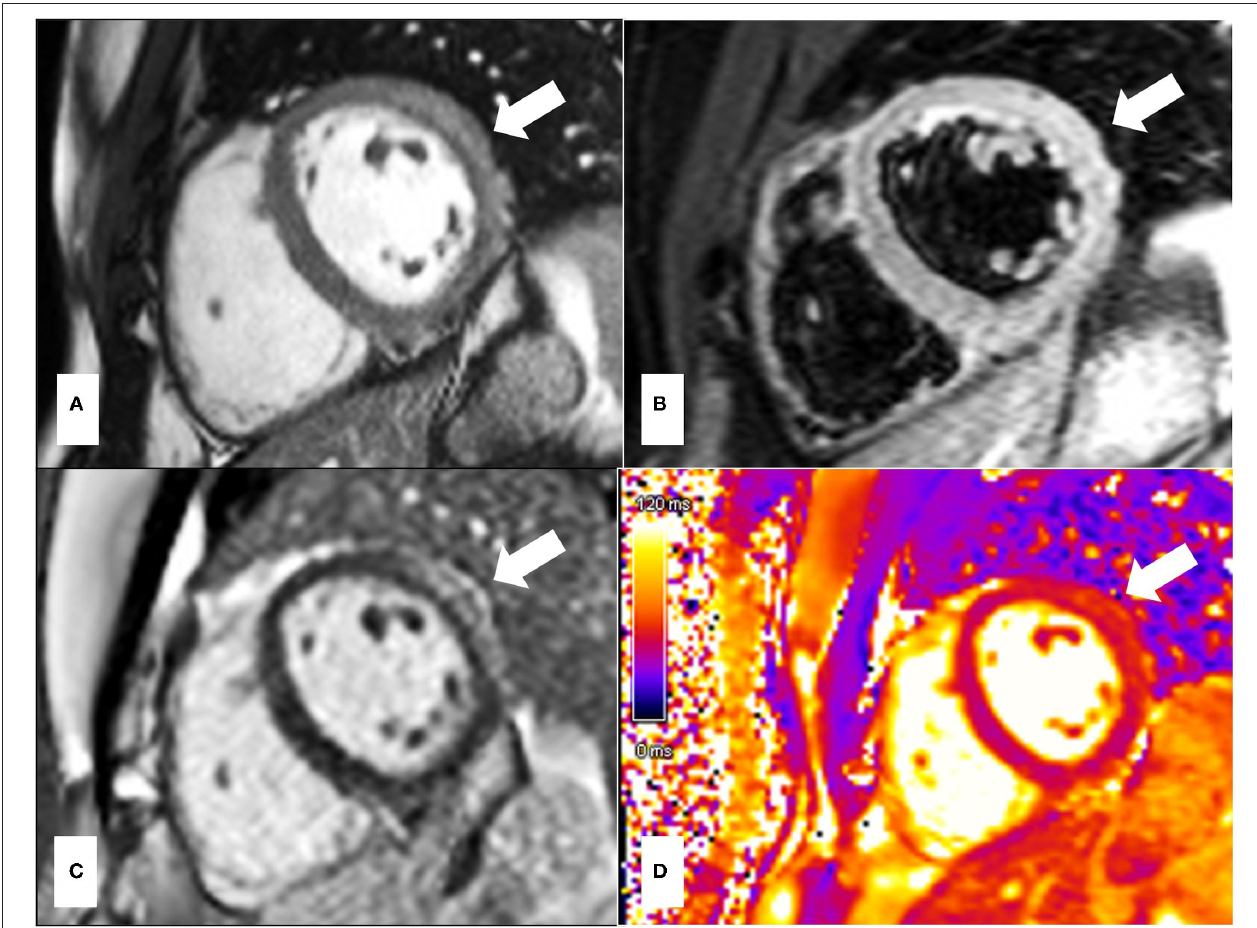
FIGURE 2 | 33-year-old presented with troponin positive chest pain and inferior ST elevation on ECG. He reported recent flu-like symptoms following mRNA COVID-19 vaccination. (A) is the post-contrast steady state free precession (SSFP) cine showing a bright signal intensity in keeping with myocardial oedema due to acute myocardial injury, which is also in keeping with the T2-STIR imaging (B) and T2 mapping (D) images which demonstrate high signal intensity in the mid lateral wall correlating with subepicardial late enhancement on gadolinium imaging (C) . The pattern of myocardial injury noted is in keeping with acute myocarditis. The areas of abnormalities are indicated by white arrows.